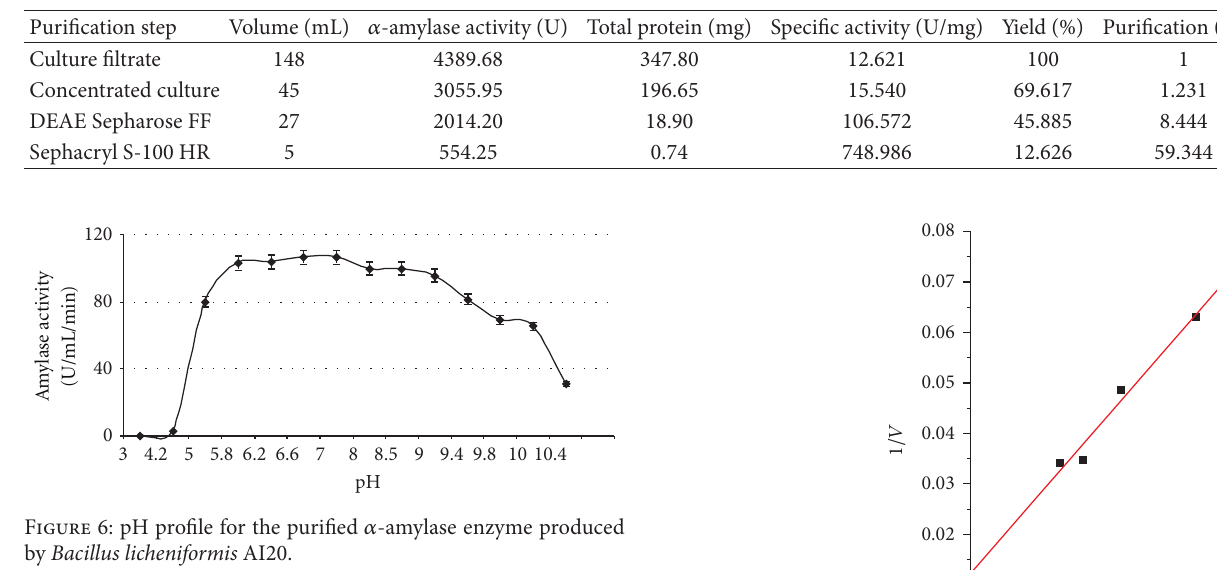
F 7: Studying the pH stability for the puri�ed enzyme produced by Bacillus licheniformis AI20.